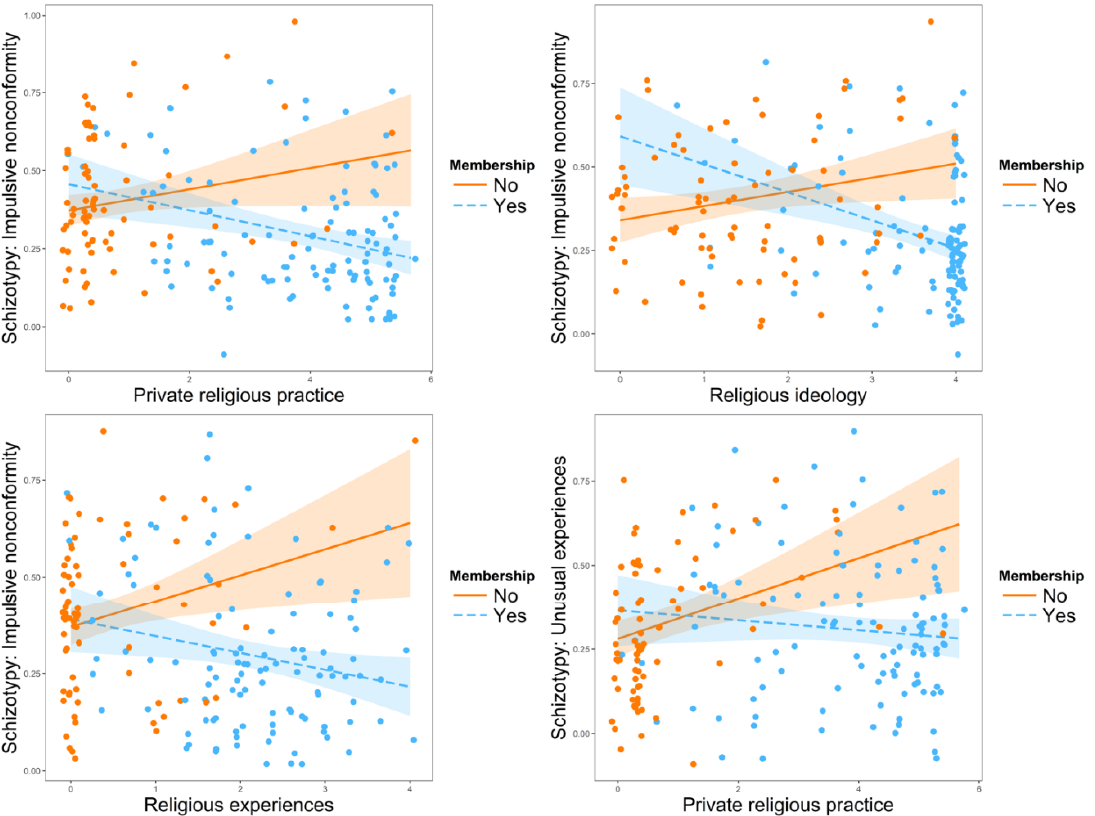
Figure 2. Associations between religiosity and schizotypy by membership in a religious community. The band represents the 95% confidence interval.